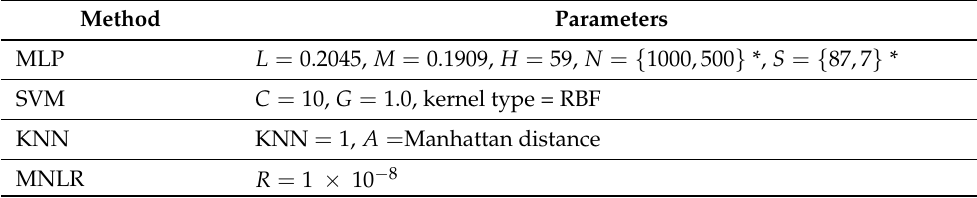
Table 9. Second experiment: classifiers’ configuration for the second test.